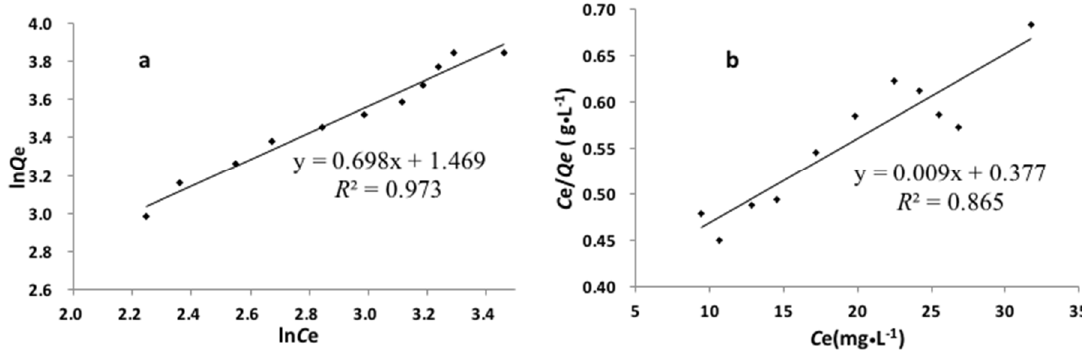
Figure 7. The fitting curves of Freundlich (a) and Langmuir (b) adsorption isotherm of MIIP.